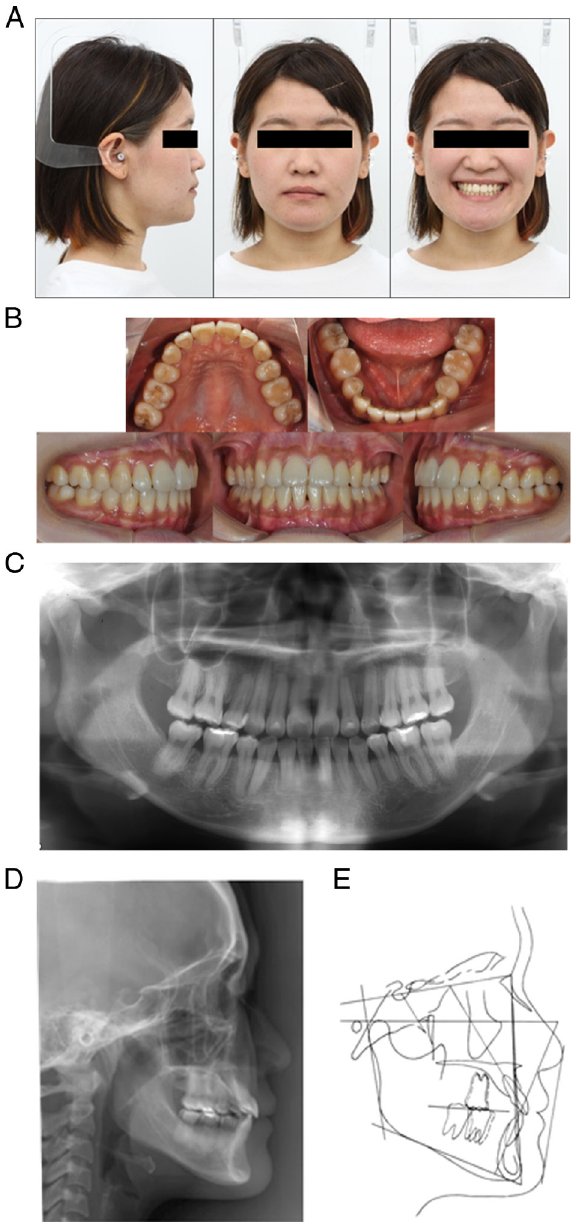
Figure 4. Posttreatment photographs and radiographs: (A) facial photo- graphs, (B) intraoral photographs, (C) panoramic radiograph, (D) lateral cephalometric radiograph and (E) lateral cephalometric tracing.